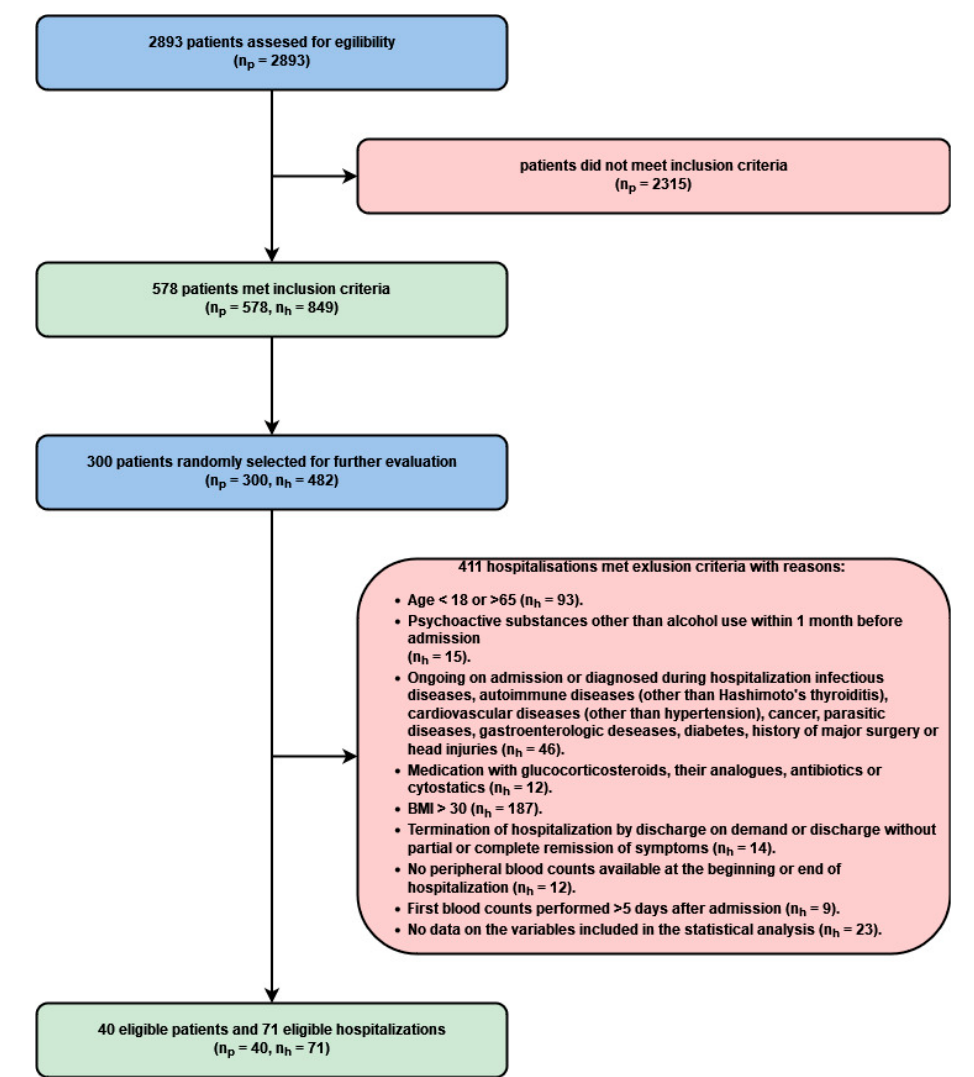
Figure 1. The process of inclusion and exclusion from the study. n p = number of patients, n h = number of hospitalizations.